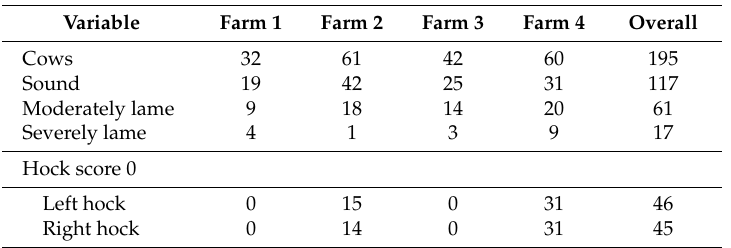
Table 1. Number of cows for each